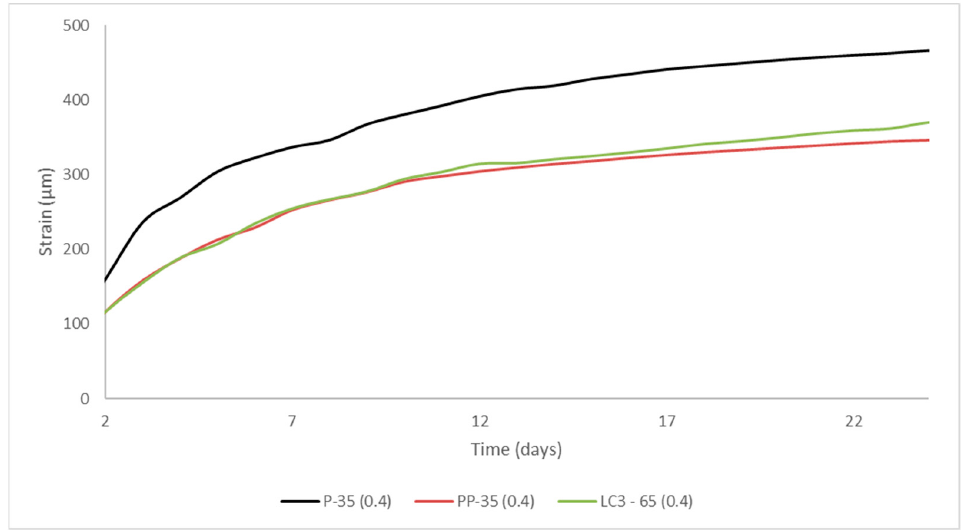
Figure 10. Long term shrinkage in concrete prisms.